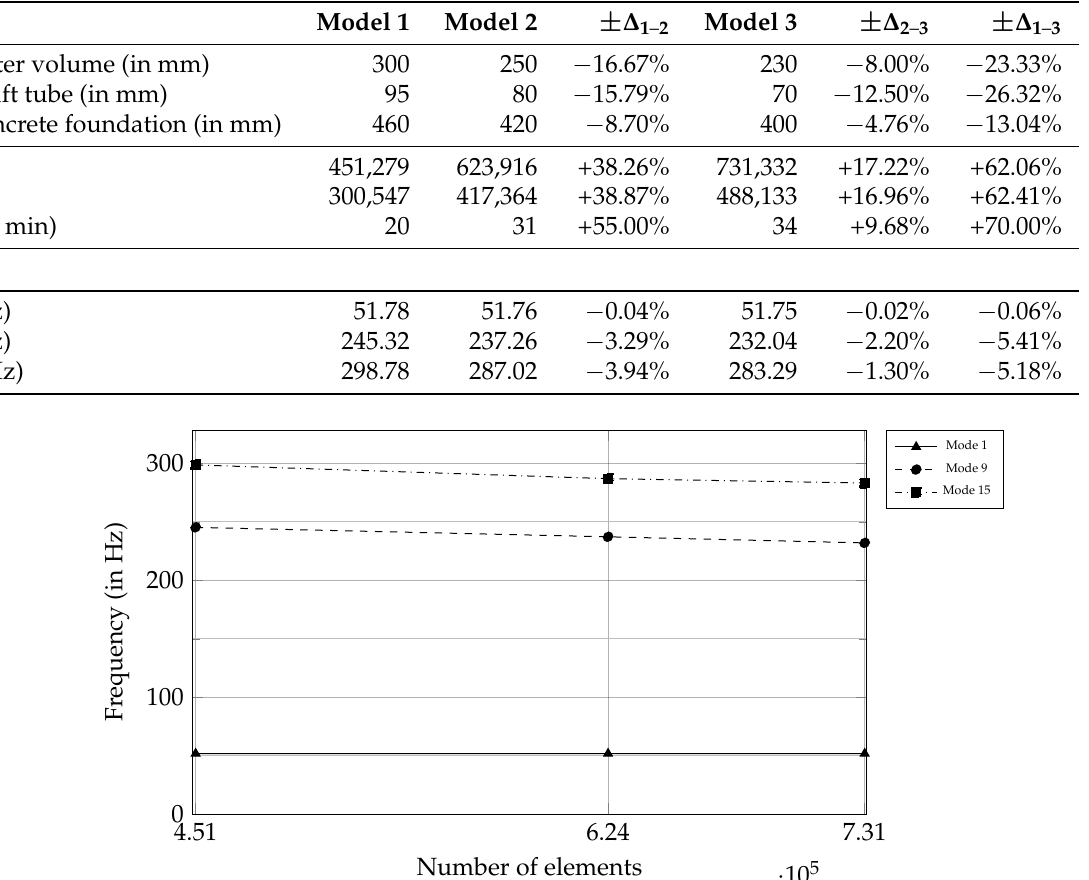
Table 5. Mesh indepence study.